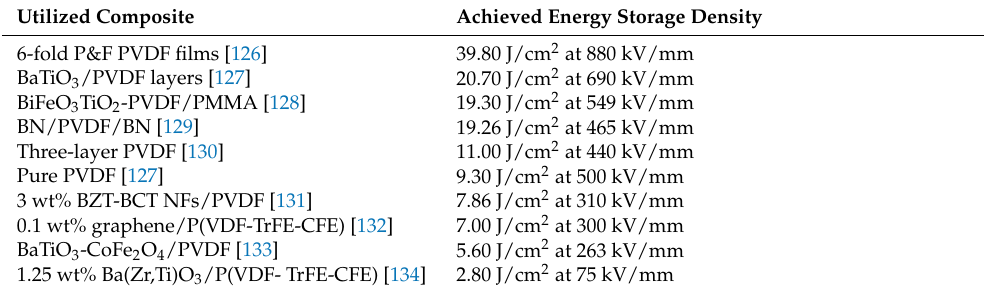
Table 5. Concise demonstration of several selected PVDF composites having high dielectric